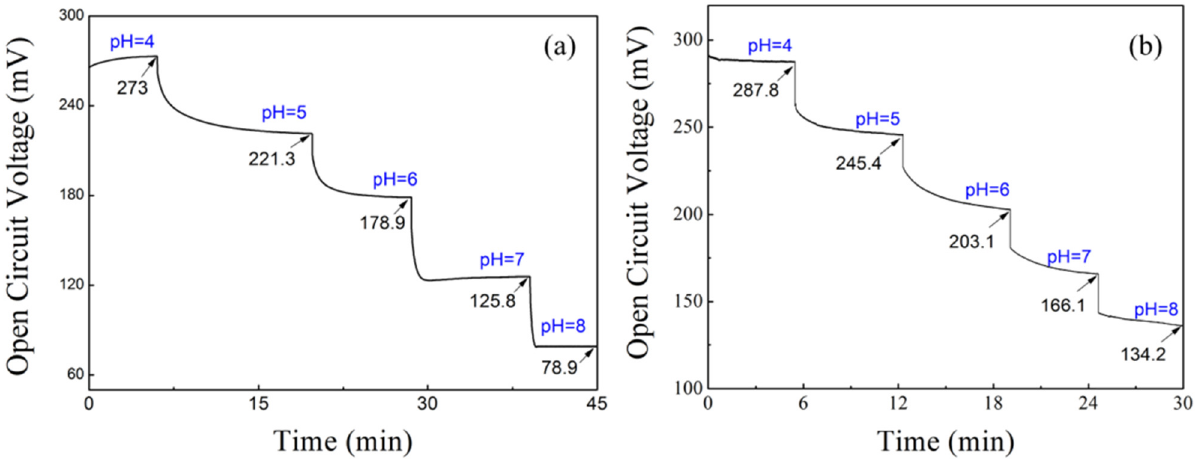
Figure 4: The pH response of ( a ) PANI/PVDF yarn and ( b ) PANI/PVDF fabric in the pH range of 4 –